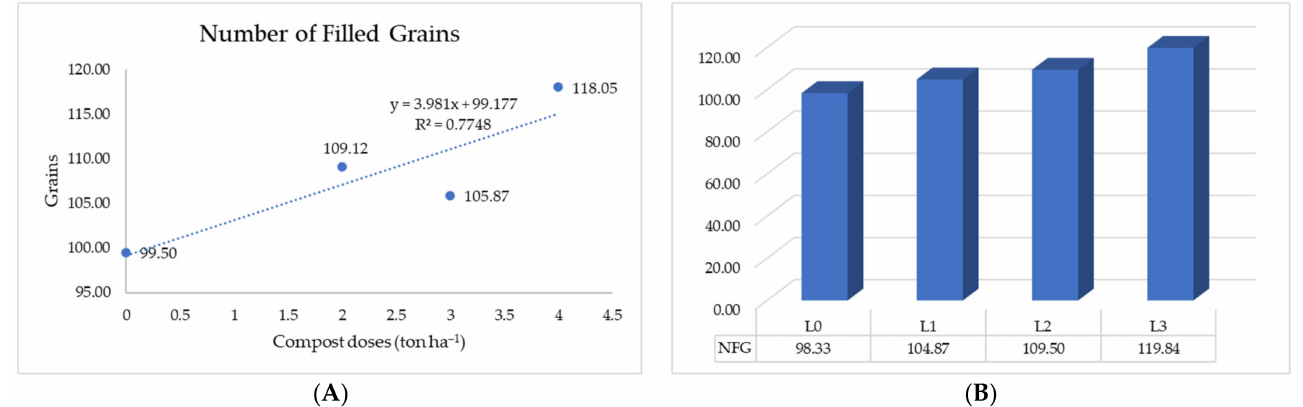
Figure 3. ( A ) Regression analysis of the effect of compost on the number of filled grains, and ( B ) honest significant difference test of the effect of the type of local liquid organic fertilizer material on the number of filled grains.